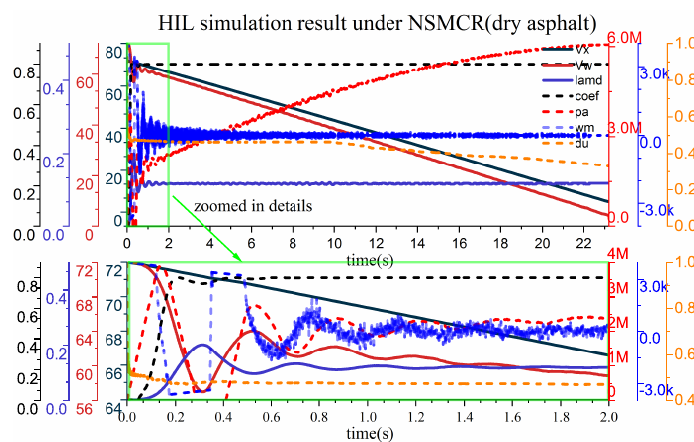
Figure 16. HIL experimental results of the NSMCR algorithm.